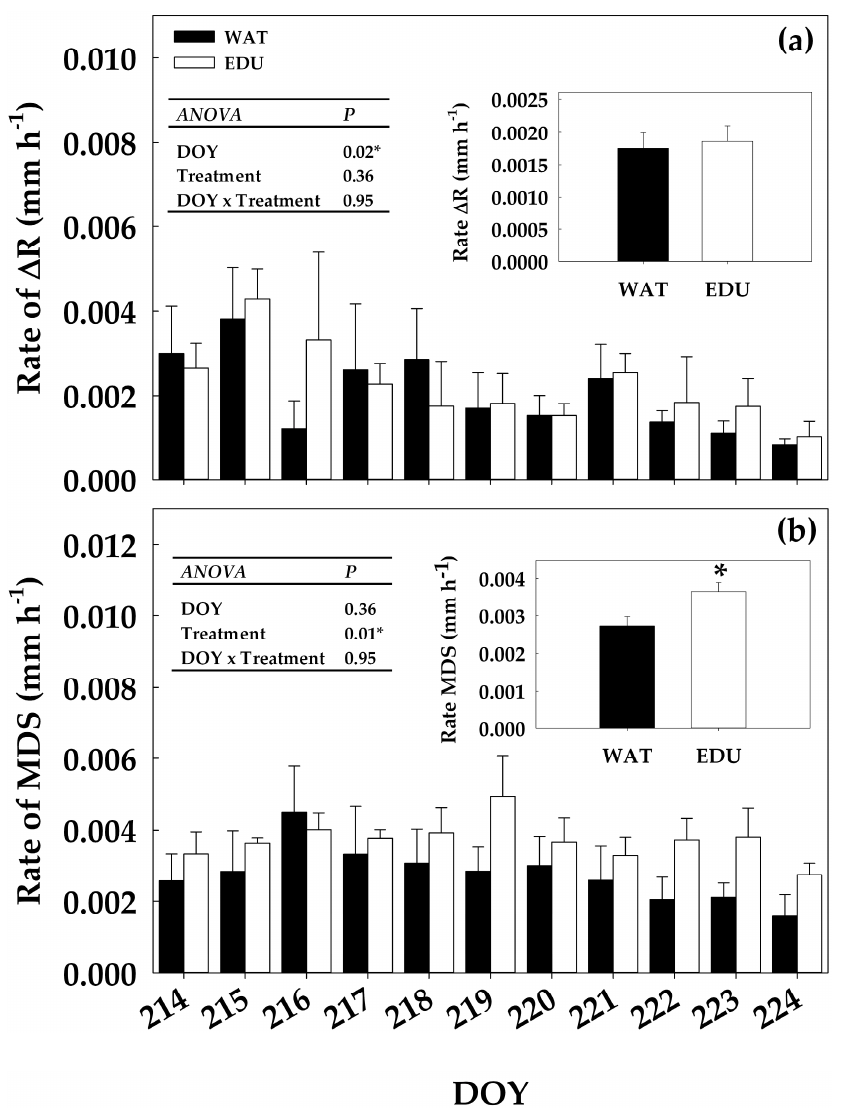
Figure 6. Rate of Δ R (Rate of stem increment), (a, ±SD) and rate of MDS (rate of maximum Figure 6. Rate of ∆ R (Rate of stem increment), (( a ), ± SD) and rate of MDS (rate of maximum daily daily shrinkage), (b, ±SD) for WAT (water treated) and EDU (EDU treated) trees from DOY shrinkage), (( b ), ± SD) for WAT (water treated) and EDU (EDU treated) trees from DOY 214 to DOY 214 to DOY 224. The bars represent the mean of five trees. Data were analyzed with two- 224. The bars represent the mean of five trees. Data were analyzed with two-way analysis of variance way analysis of variance (ANOVA) and the results were reported in the inset table. The (ANOVA) and the results were reported in the inset table. The inset graphic represents the mean of rate inset graphic represents the mean of rate of Δ R and rate of MDS calculated on 10 days ( N = of ∆ R and rate of MDS calculated on 10 days ( N = 5). Asterisks indicate significant di ff erences between 5). Asterisks indicate significant differences between treatments ( p < 0.05). treatments ( p <